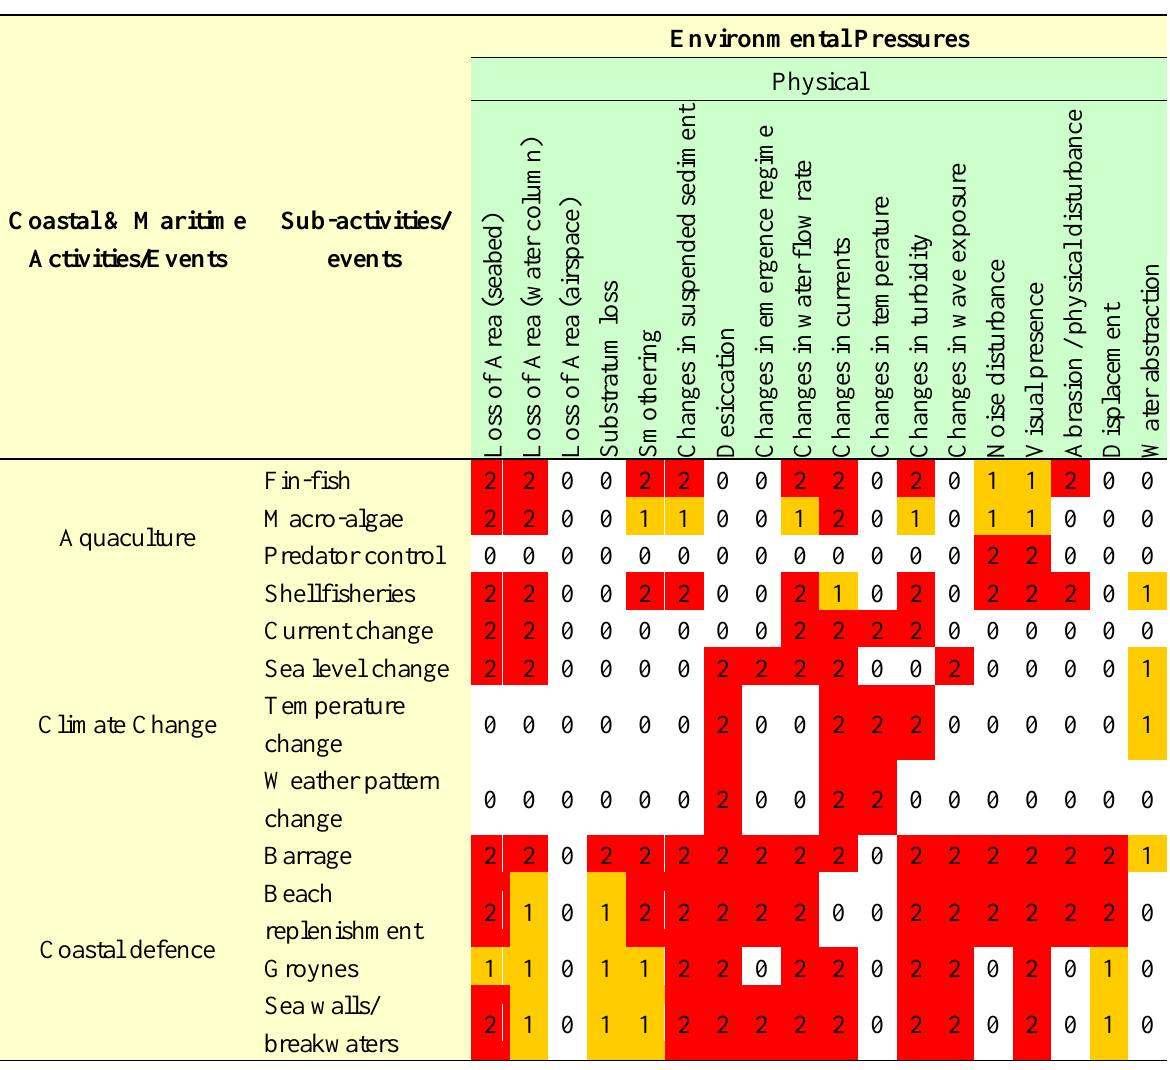
Table 3. Section of the offshore activity comparison matrix (showing previous scoring system, without positive and negative values, and physical pressures only—biological and chemical pressures are included in the full